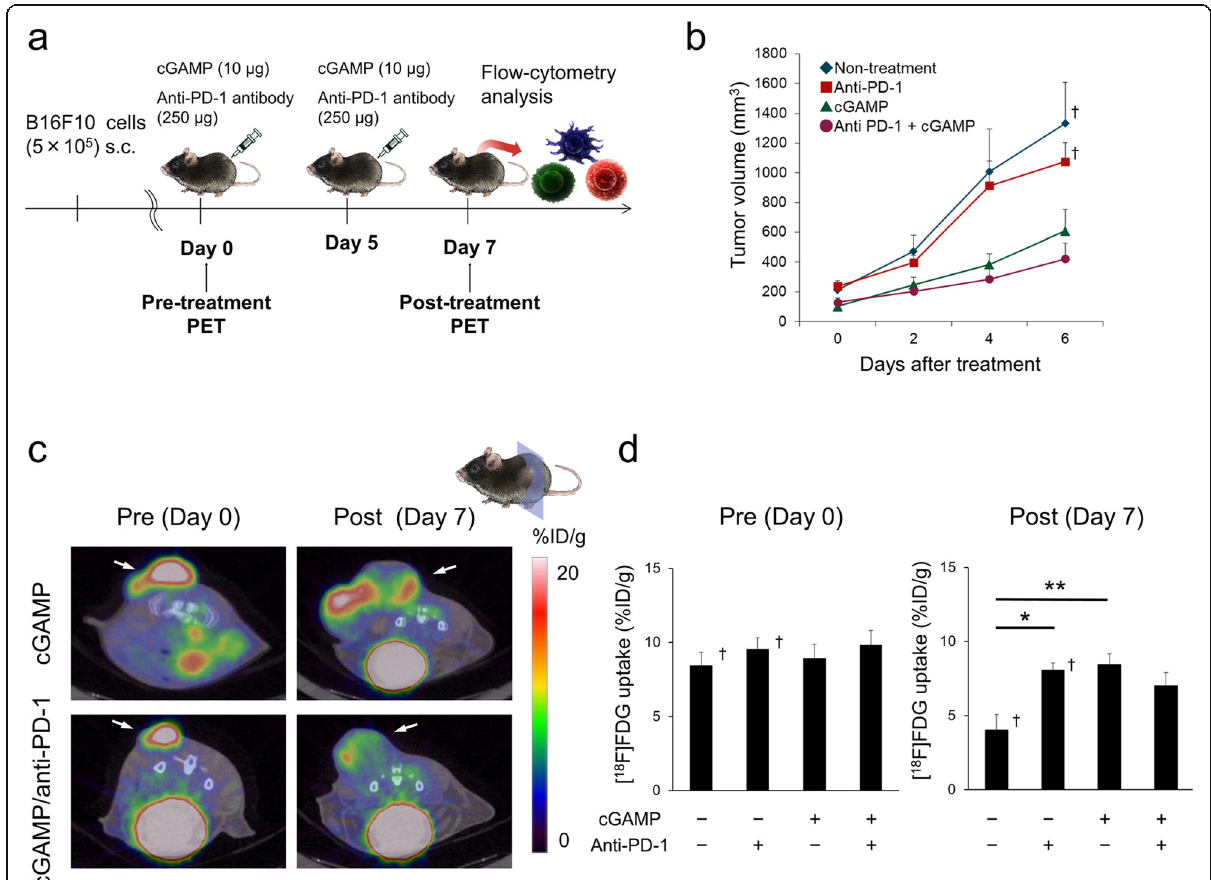
Fig. 1 [ 18 F]FDG uptake after anti-PD-1 treatment in cGAMP injected mice . a Illustration of in vivo and ex vivo study timelines. b Tumor growth curves after anti-PD-1 or cGAMP treatment ( n = 14 – 27). Data of the non-treatment group and anti-PD-1 treated group were quoted from [11]. c Coronal images from [ 18 F]FDG-PET/CT scans from cGAMP alone treated (top) or cGAMP/anti-PD-1 combination treated (bottom) mice on days 0 and 7. d [ 18 F]FDG uptake was calculated by PET-CT images in tumors on days 0 and 7 ( n = 6 – 7). Data of the non-treatment group and anti-PD-1- treated group were quoted from [11]. Data represent the mean ± SEM; * p < 0.05; ** p < 0.01; † Adapted from